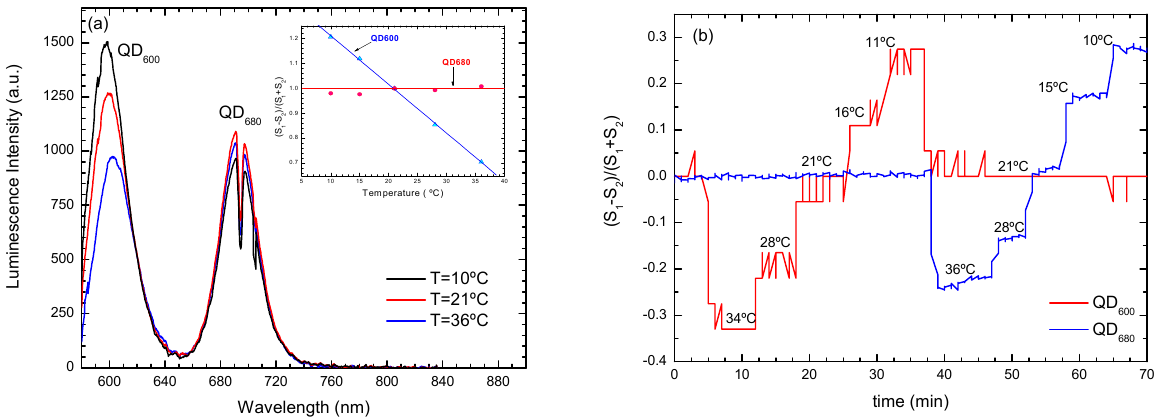
Figure 9. a) Spectral response of two distinct QD samples (QD of temperature (inserted: Normalized S